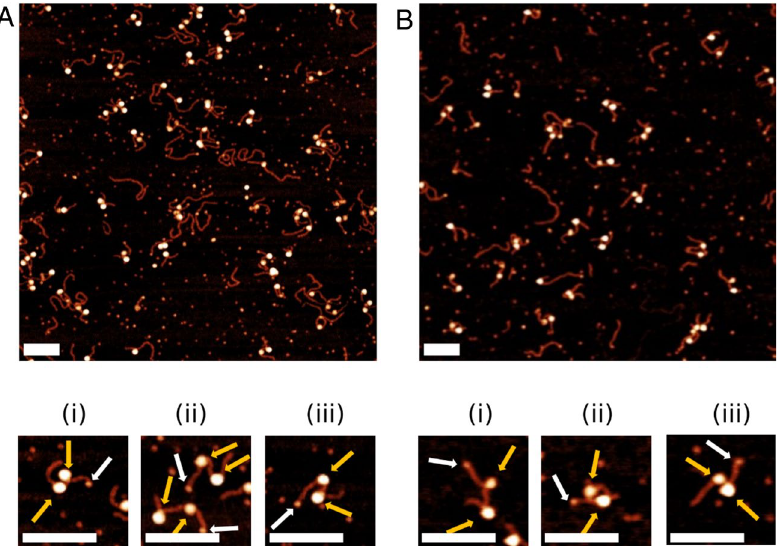
Figure 4. Representative images of dinucleosome samples assembled on the double positioning sequence with snapshots below. White arrows indicate rhizavidin and gold arrows indicate the nucleosome core. Scale bars indicate 100 nm. (i), (ii), and (iii) show nucleosomes with different internucleosomal distances. ( A ) Canonical dinucleosomes. ( B ) H4 truncated dinucleosomes.